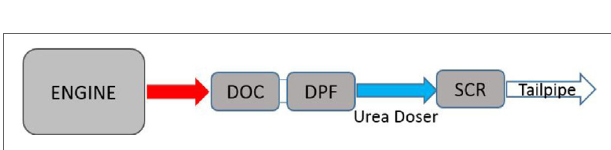
FigUre 5 | A diesel engine aftertreatment (A/T) system consists of discrete emission reducing modules, along with a urea injection system and required instrumentation like thermocouples and emission measurements. Note that the SCR in the test setup is currently used in the passive mode without any urea injection.